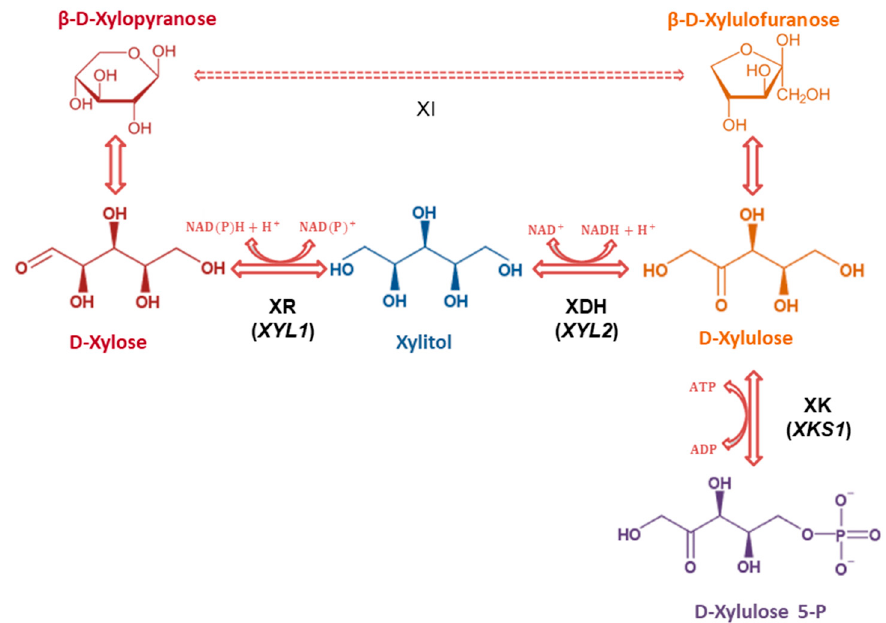
Figure 1. Xylose utilization pathways in fungi. Xylose can be directly isomerized (XI) to xylulose, or this pentose is first reduced (XR) to xylitol and then oxidized (XDH) to xylulose. Both pathways require the activity of xylulokinase (XK) that will enable xylulose-5-P to enter the nonoxidative part of the pentose phosphate pathway and glycolysis [12]. The overexpressed genes in strain DLG-K1 are indicated.